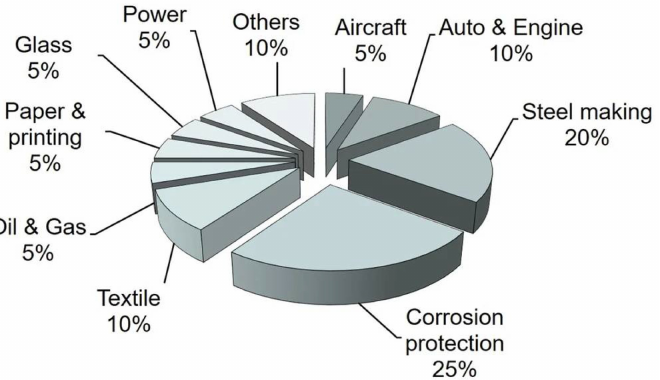
Figure 4. Estimated distribution of thermal spray applications in China in year 2008. Adapted with permission from [20]. 2008, Springer